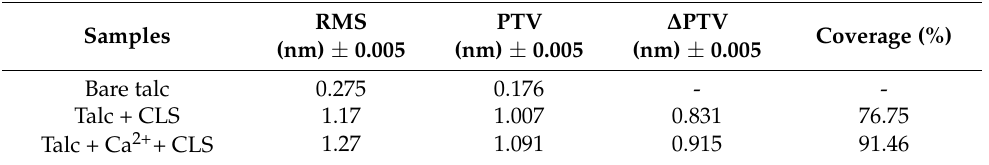
Table 3. Morphological details (RMS, PTV, ∆ PTV, and coverage) for CLS adsorbed on